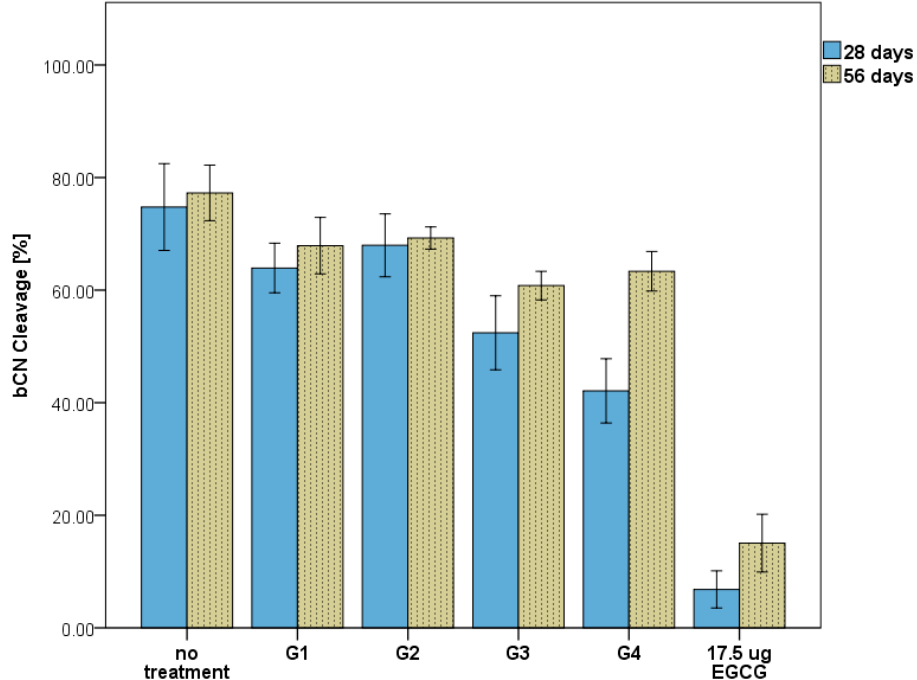
Figure 4. Total cleavage of bCN by MMP-9 detected by the intensity band relative to the baseline.